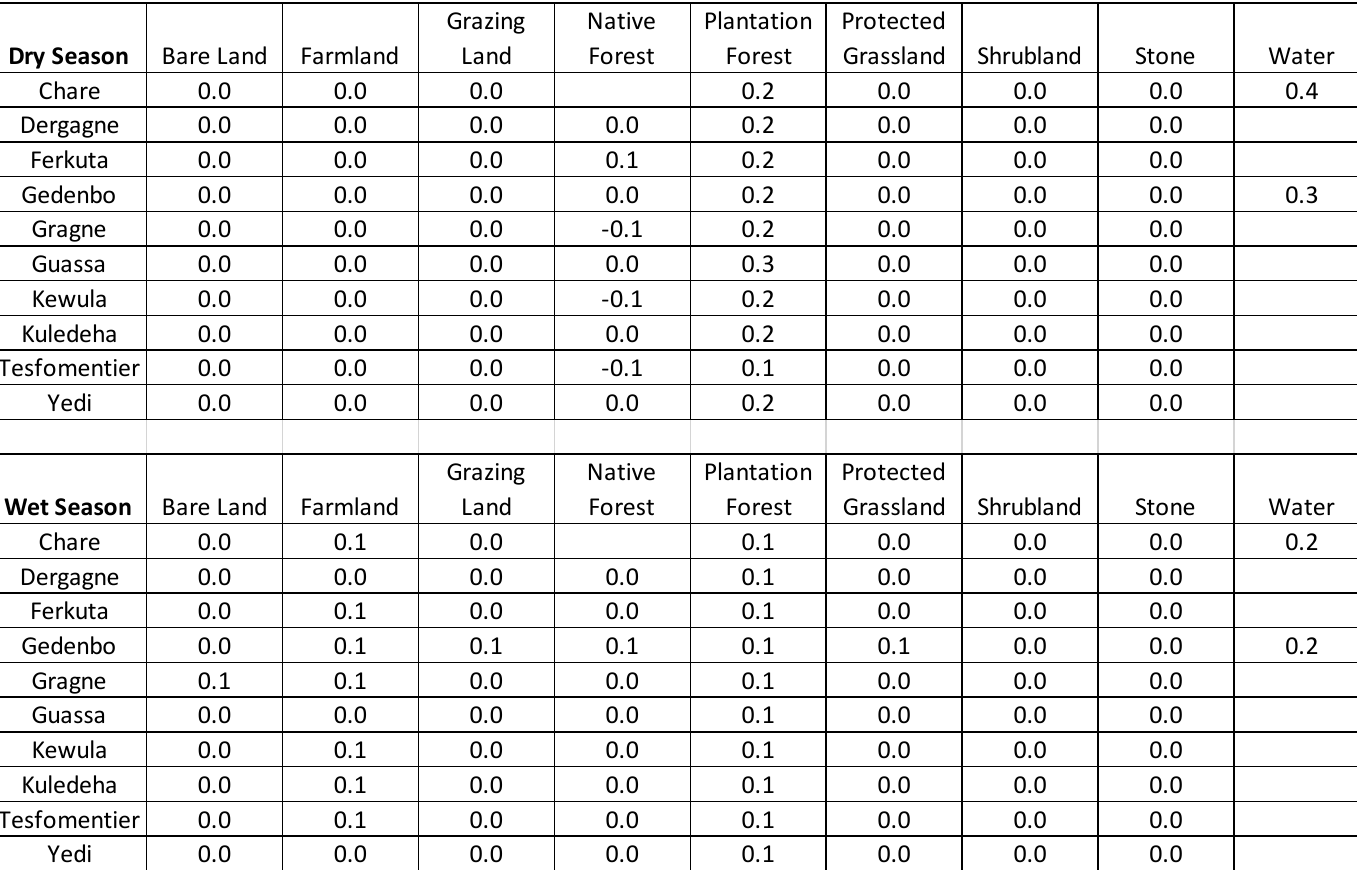
Table A1.6. Mean NBR change values from Derg to the Co-management period, by land